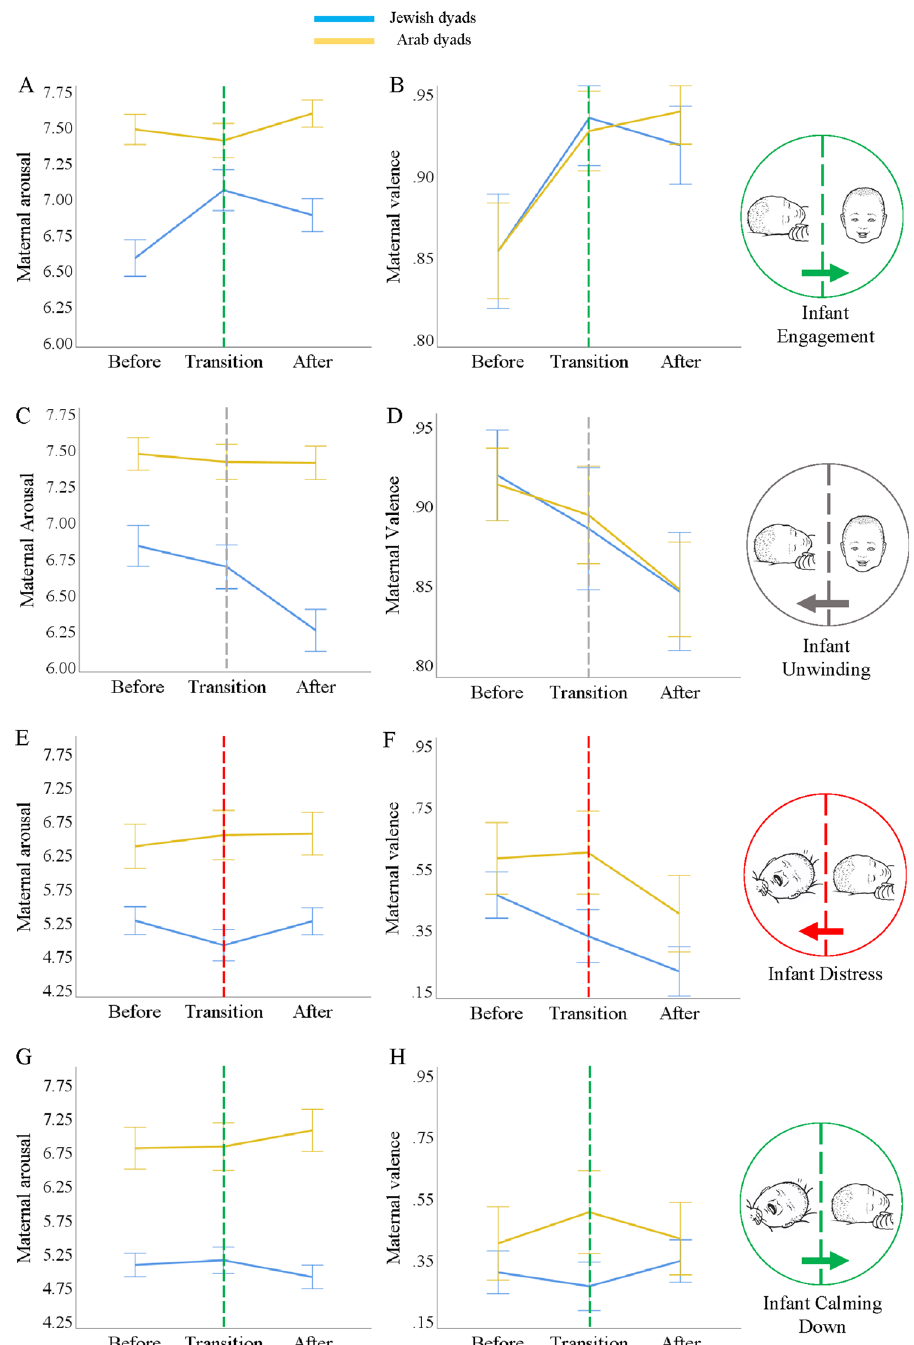
Figure 3. Maternal changes in valence and arousal during infant engagement, distress, unwinding, and calming down. The X-axes represent time, where multiple events of infant play or distress are temporally aligned in time at x = 0. Y-axes represent maternal social display of valence or arousal during infant play, distress, unwinding, and calming down. Error bars represent 1 standard error (SE). ( A ) Maternal arousal during infant engagement. ( B ) Maternal valence during infant engagement. ( C ) Maternal arousal during infant unwinding. ( D ) Maternal valence during infant unwinding. ( E ) Maternal arousal during infant distress. ( F ) Maternal valence during infant distress. ( G ) Maternal arousal during infant calming down. ( H ) Maternal valence during infant calming